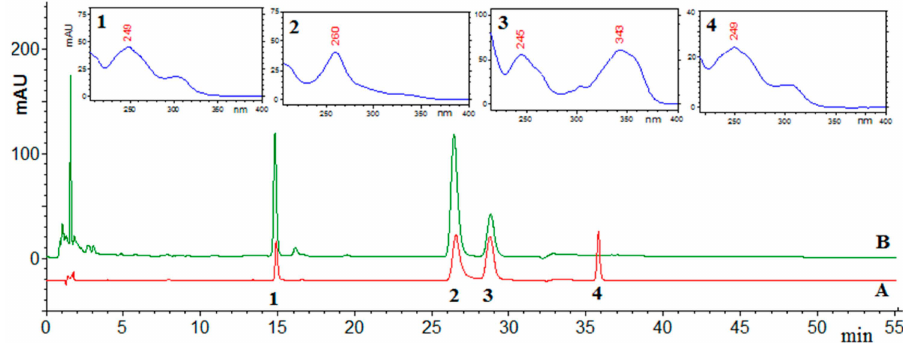
Figure 1. The example of chromatogram: A—mixture of standard and B—hydrolyzed